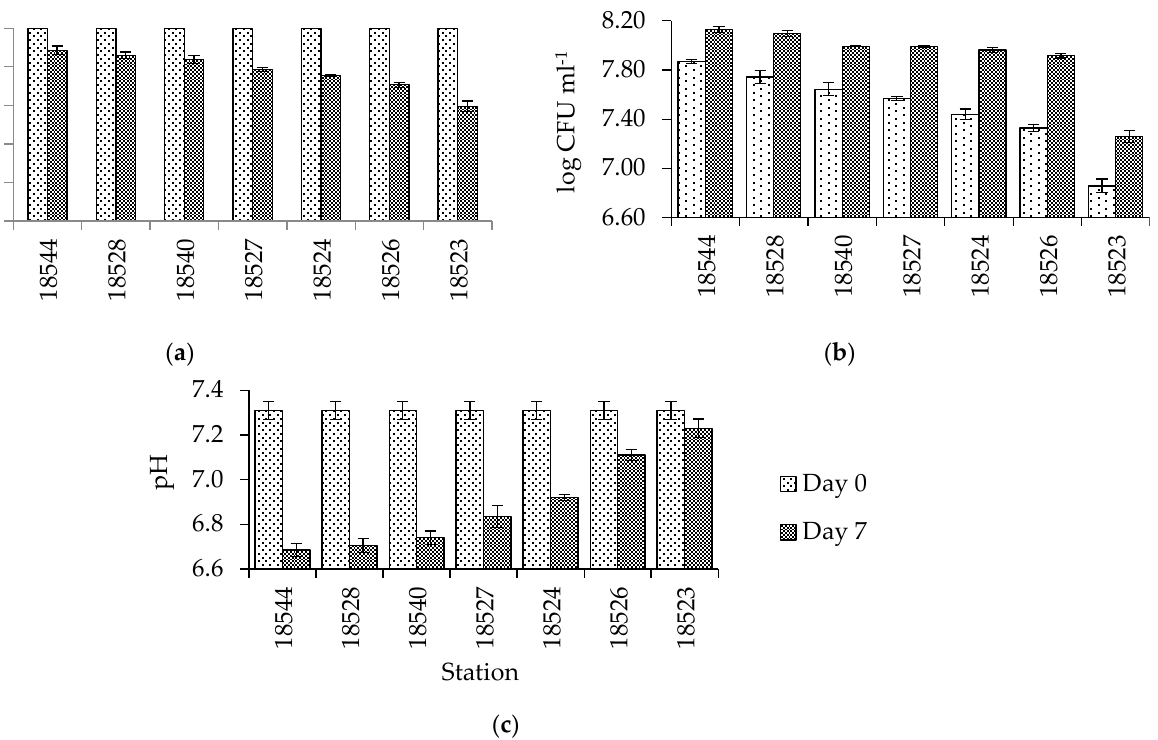
Figure 3. The properties of the oil degradation experiment with consortium bacteria extracted from 7 sediment samples before and after a 7 − day experiment: ( a ) percentage of oil and grease content, ( b ) the number of the mixed bacterial population, and ( c ) pH condition with standard deviation.